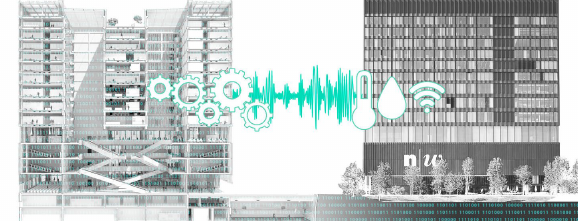
Figure 7. Connection through IoT is needed to connect the building with its digital representation or